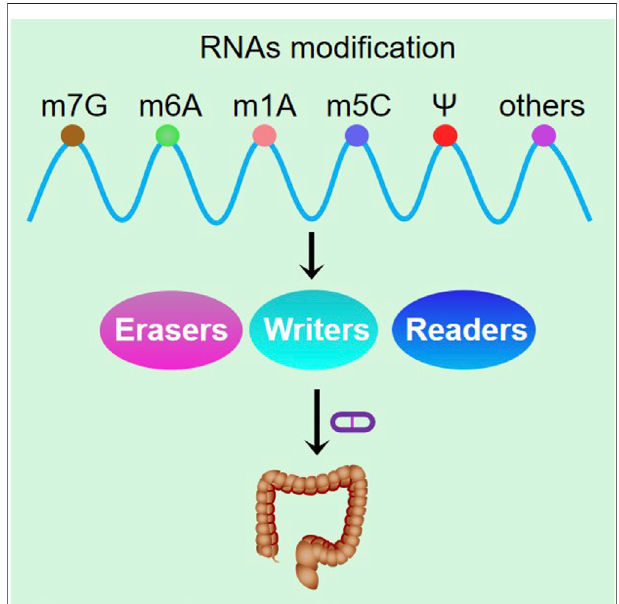
FIGURE 4 | Schematic diagram of RNA methylation application in the